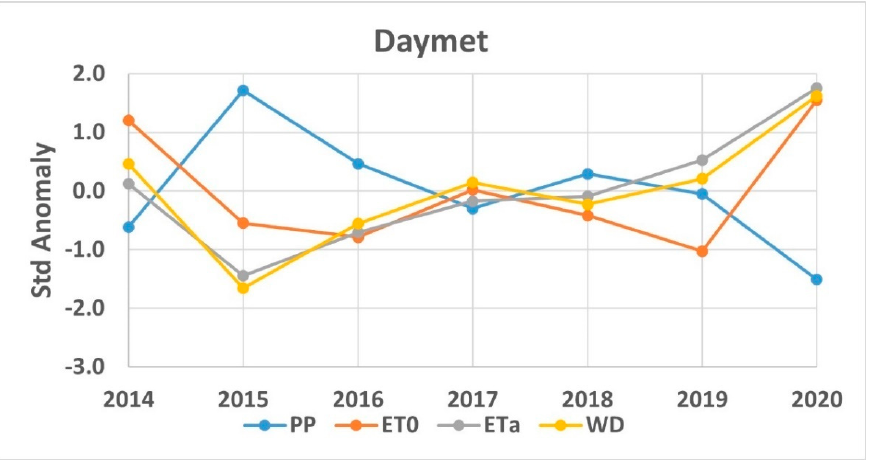
Figure 10 . Standardized anomalies as line graphs of key water metrics, precipitation (PP), potential ET (ETo), actual ET (ETa), and water deficit (WD), for seven years (2014–2020) with weather data acquired using Daymet (gridded, 1 km) but produced at 30 m resolution for the northeast corner of Arizona, which includes a large portion of the Navajo Nation.